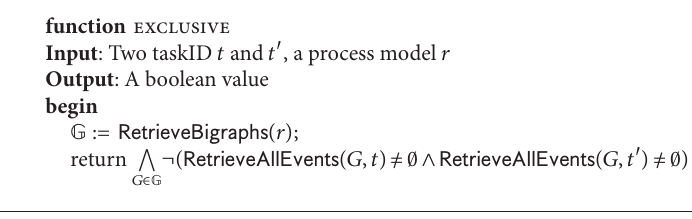
Algorithm 8: Determining the basic predicate exclusive .